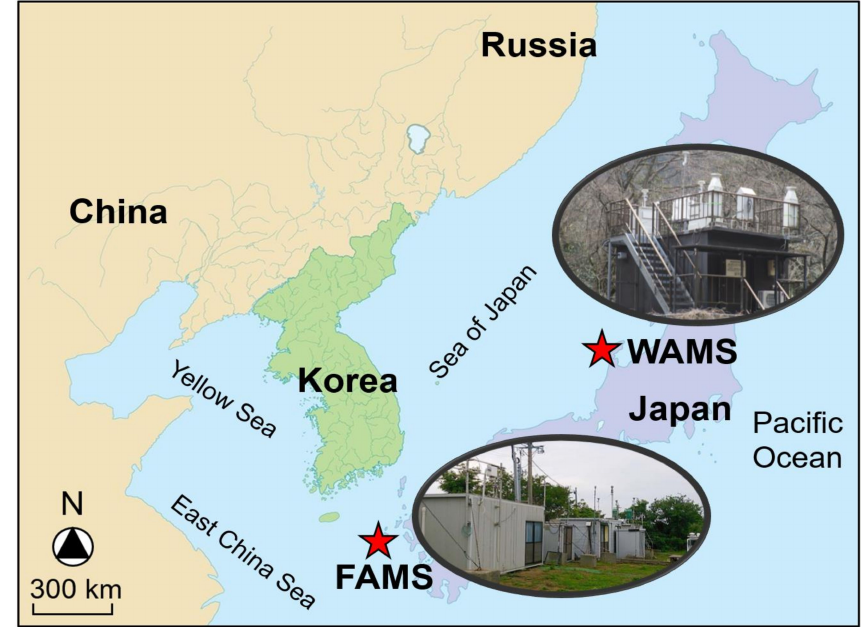
Figure 1. Location of Wajima Air Monitoring Station (WAMS; 37º21 (cid:48) 05” N, 136º47 (cid:48) 33” E) and Fukue-Jima Atmosphere and Aerosol Monitoring Station (FAMS; 32º45 (cid:48) 07” N, 128º40 (cid:48) 59” E),